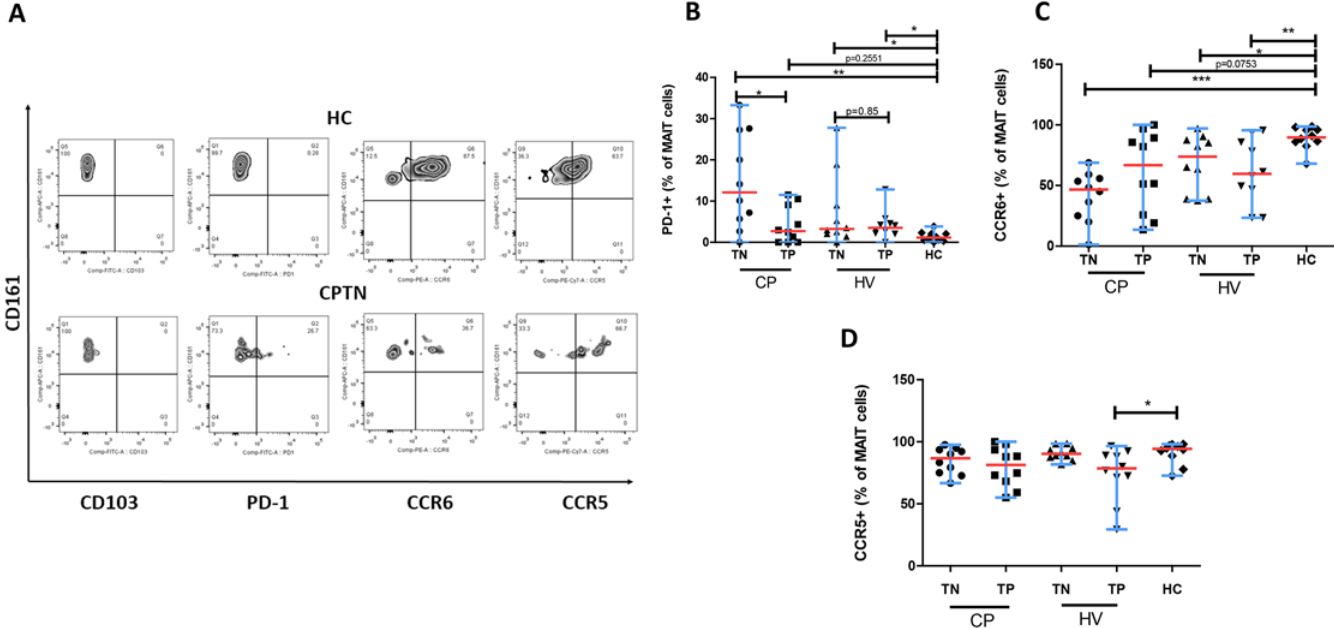
Fig 3. Expression levels of different markers by CD161 ++ CD8 + T-cell subsets in the study population. (A) Zebra plots of double-gating strategy (gated on the CD161 ++ CD8 + T cells) show staining with 4 different markers (CD103, PD-1, CCR6, CCR5) on representative samples from a HC and a CPTN. HCs showed increased amount of CCR6-expressing MAIT cells and decreased amount of PD-1 expressing MAIT cells compared to CPTNs. (B) HC showed significantly lower expression level of inhibitory receptor, PD-1 while HIV/TB co-infected patients show significantly increased PD-1 expressing MAIT cells. (C) Significantly increased CCR6-expressing MAIT cells were found in HCs compared to HIV and TB infected groups. (D) No significant difference was observed in CCR5 expression levels by MAIT cells among the different study subjects. The significant difference in CCR5 expression between HVTPs and HCs may be due to the limited number of samples. All graphs show median (red bars) and range (blue whiskers); P values are reported for two-sided Mann- Whitney tests with threshold for significance P = 0.025 after Bonferroni correction for 2 comparisons. (Note: TN, treatment na ï ve; TP, treatment positive; HC, healthy control; CP, HIV/TB co-infection; HV, HIV